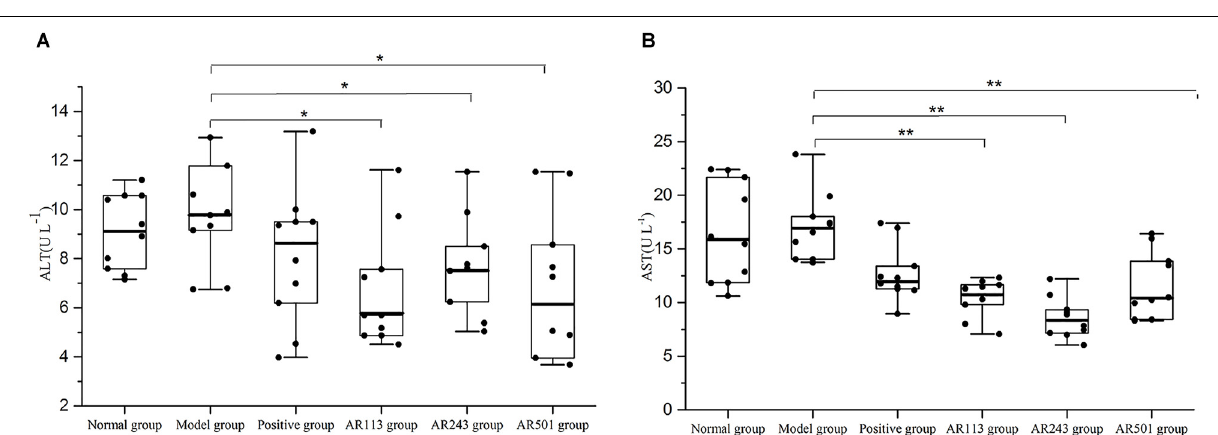
FIGURE 2 | Effect of LAB on serum enzyme activities of (A) alanine aminotransferase (ALT) and (B) aspartate aminotransferase (AST) levels. Where U/L means the biological value of ALT or AST in per liter serum. Values are expressed as mean ± SD ( n = 10), ∗ p < 0.05 vs. model group, ∗∗ p < 0.01 vs. model group.